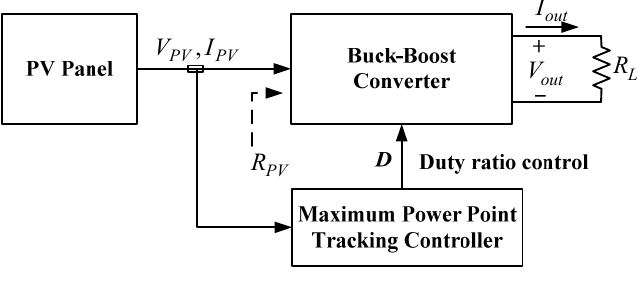
Figure 3. Solar power maximum power point tracking system.